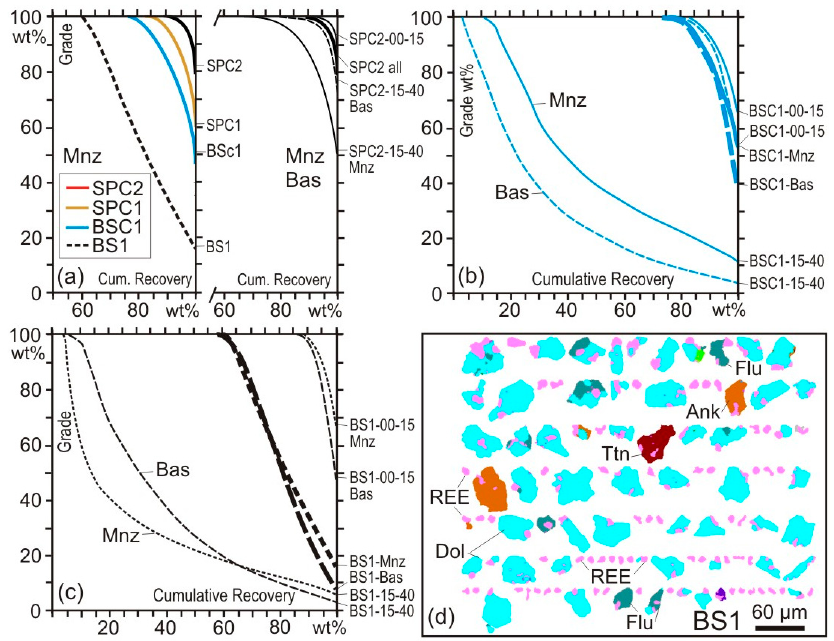
Figure 6. ( a – c ) Mineral grade vs recovery curves of REE carbonatite ore samples in mineral processing tests involving multistage flotation. Data of 100 wt % cumulative recovery is given by the mode of bastnaesite (Bas—broken lines) and REE-P-monazite (Mnz). Data of 100 wt % mineral grade is given by the proportion in wt% of fully liberated grains, extracted from the mineral liberation data in Figure 5d. SPC2—second cleaner concentrate; SPC1—scavenger cleaner concentrate; BSC1—scavenger cleaner middlings; BS1—scavenger tailings. Data for the complete samples in thick lines; data for particle